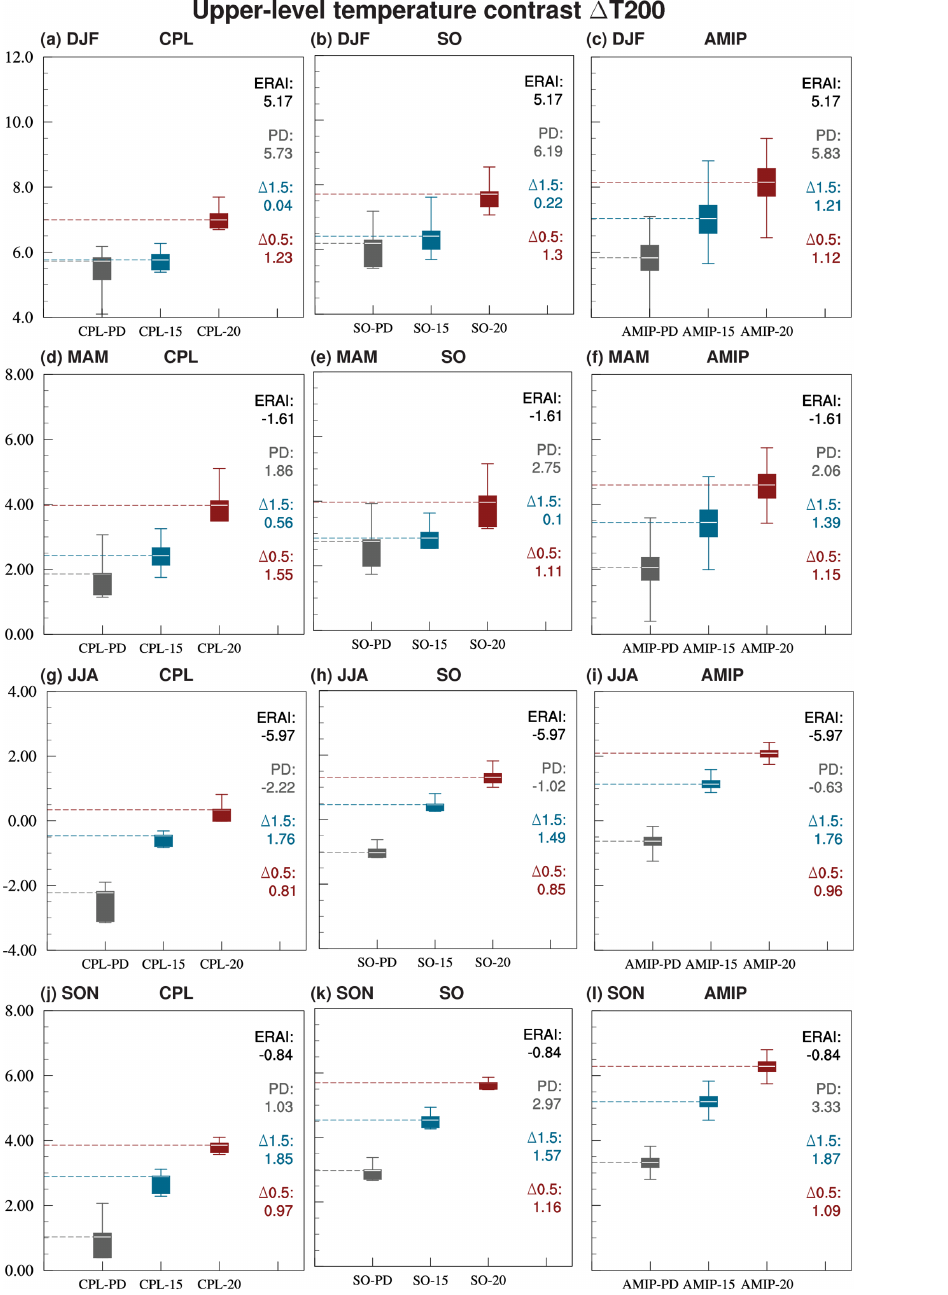
www.earth-syst-dynam.net/10/569/2019/ Earth Syst. Dynam., 10, 569–598,